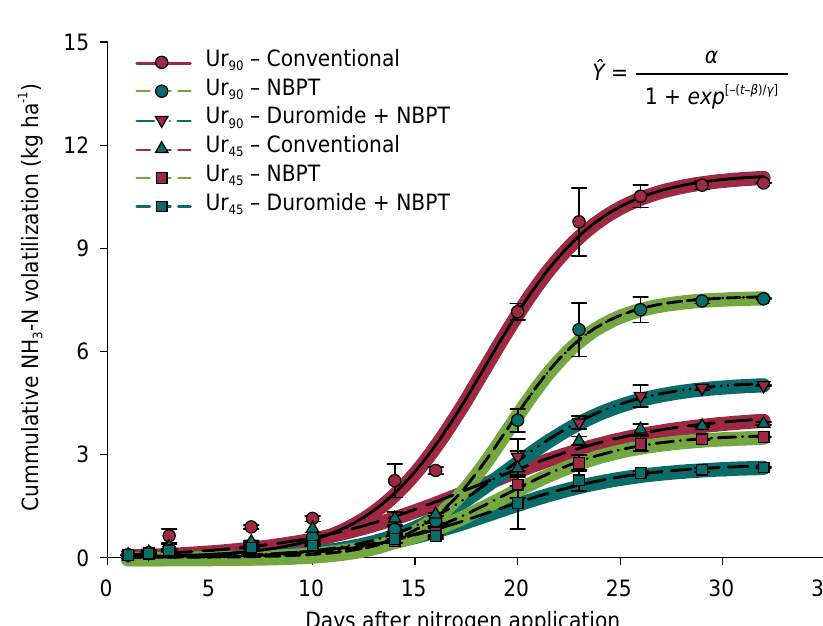
Figure 2. Cumulative volatilization NH 3 -N after broadcast applications of urea (Ur), Ur-NBPT, and Ur-Duromide + NBPT for N rate of 45 and 90 kg ha -1 . Data with overlapping vertical bars with 95 % confidence interval in the